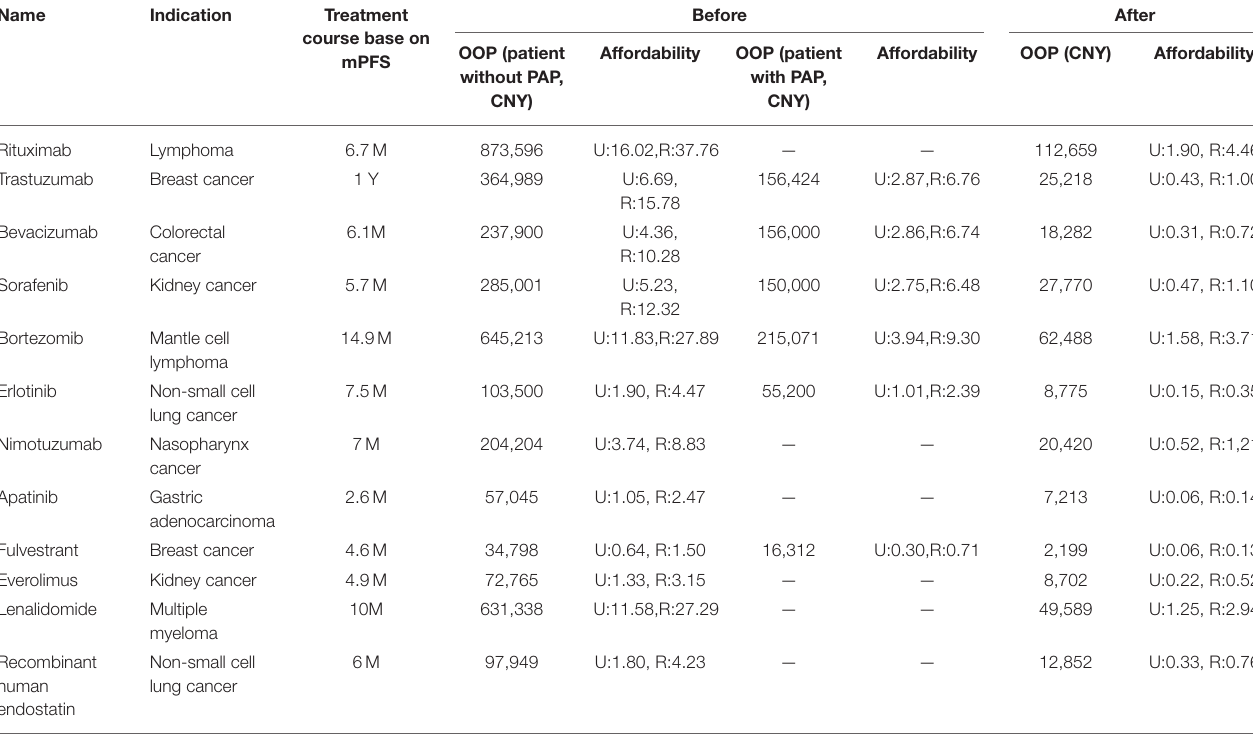
TABLE 6 | The change of patient affordability for mPFS treatment course before and after the NHIC policy.